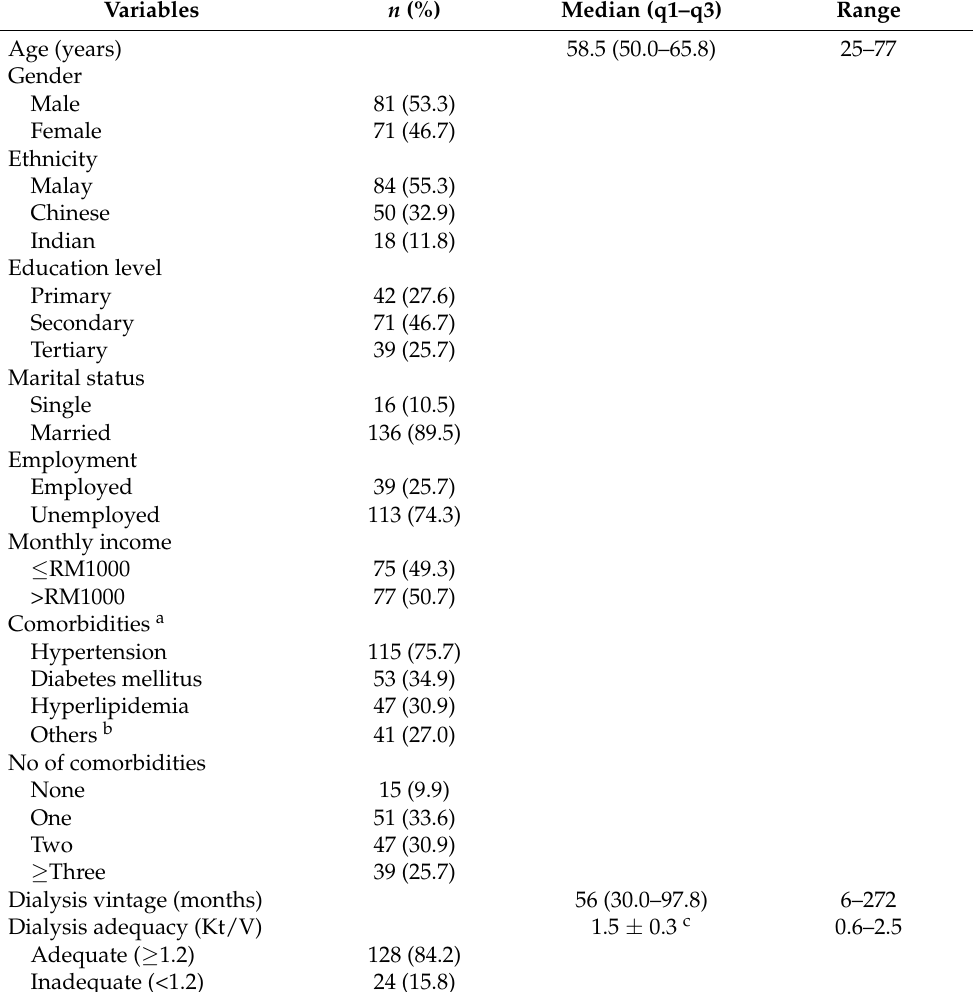
Table 1. Patients’ Characteristics ( n =